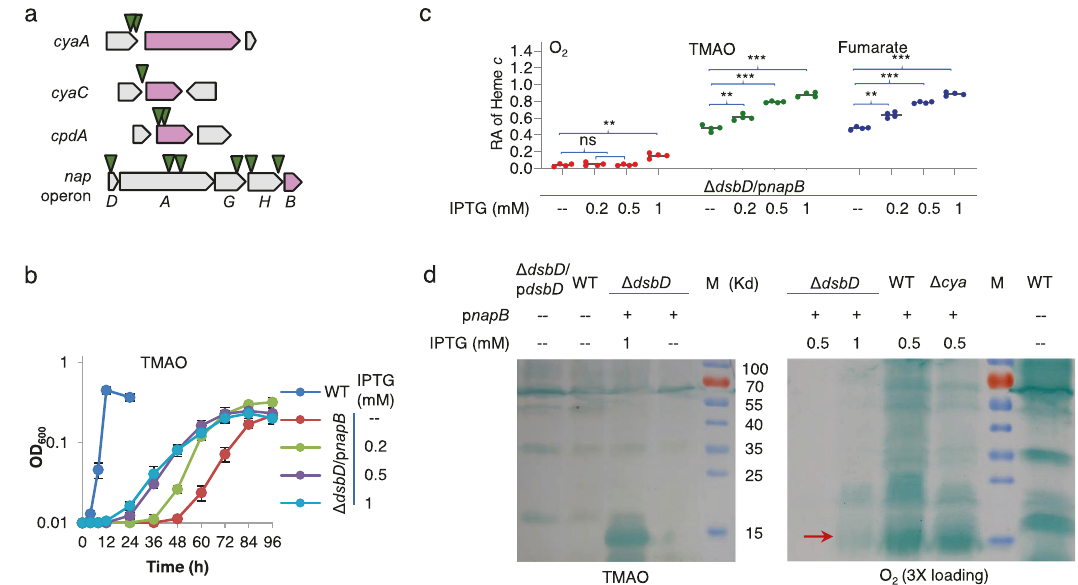
Fig. 4 Identi fi cation of NapB as the protein facilitating cyt c biosynthesis of the dsbD mutant. a Screening for better growth mutants from Δ dsbD by transposon mutagenesis. The transposable element contains robust promoters, aiming at overproducing genes after the insertion. By genetic mapping, 11 random mutants had insertions shown here, which was drawn in scale. Arrows represent the approximate locations of transposon insertions. b Impacts of NapB at varying levels on growth on EAs speci fi ed. Expression of napB (p napB ) was driven by IPTG-inducible promoter P tac . The experiments were performed four times, and the data were presented as the average ± SD (error bar). c Heme c levels in strains grown to the early stationary phase. The relative abundance (RA) of heme c was obtained as described in Fig. 2b. Asterisks indicate statistically signi fi cant difference of the values compared ( n = 4; ns not signi fi cant, p > 0.05; * P < 0.05; ** P < 0.01; *** P < 0.001). d Heme-staining. Samples prepared the same as for quanti fi cation of heme c were processed, protein contents were quanti fi ed, and the equal amounts of proteins were separated in SDS-PAGE, and then subjected to heme-staining. Δ dsbD /p dsbD , complemented Δ dsbD , M molecular weight marker. NapB was indicated by arrows. Aerobic growth samples were overloaded (3X) for better